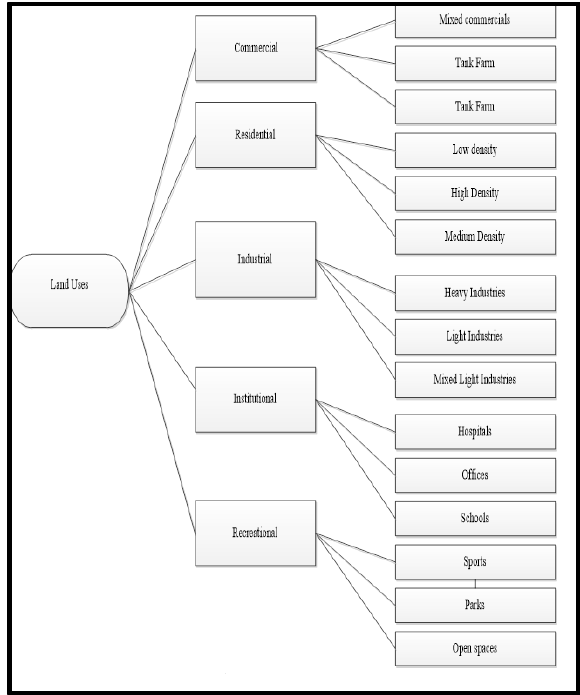
Figure 4: Land-Use Classes and their sub